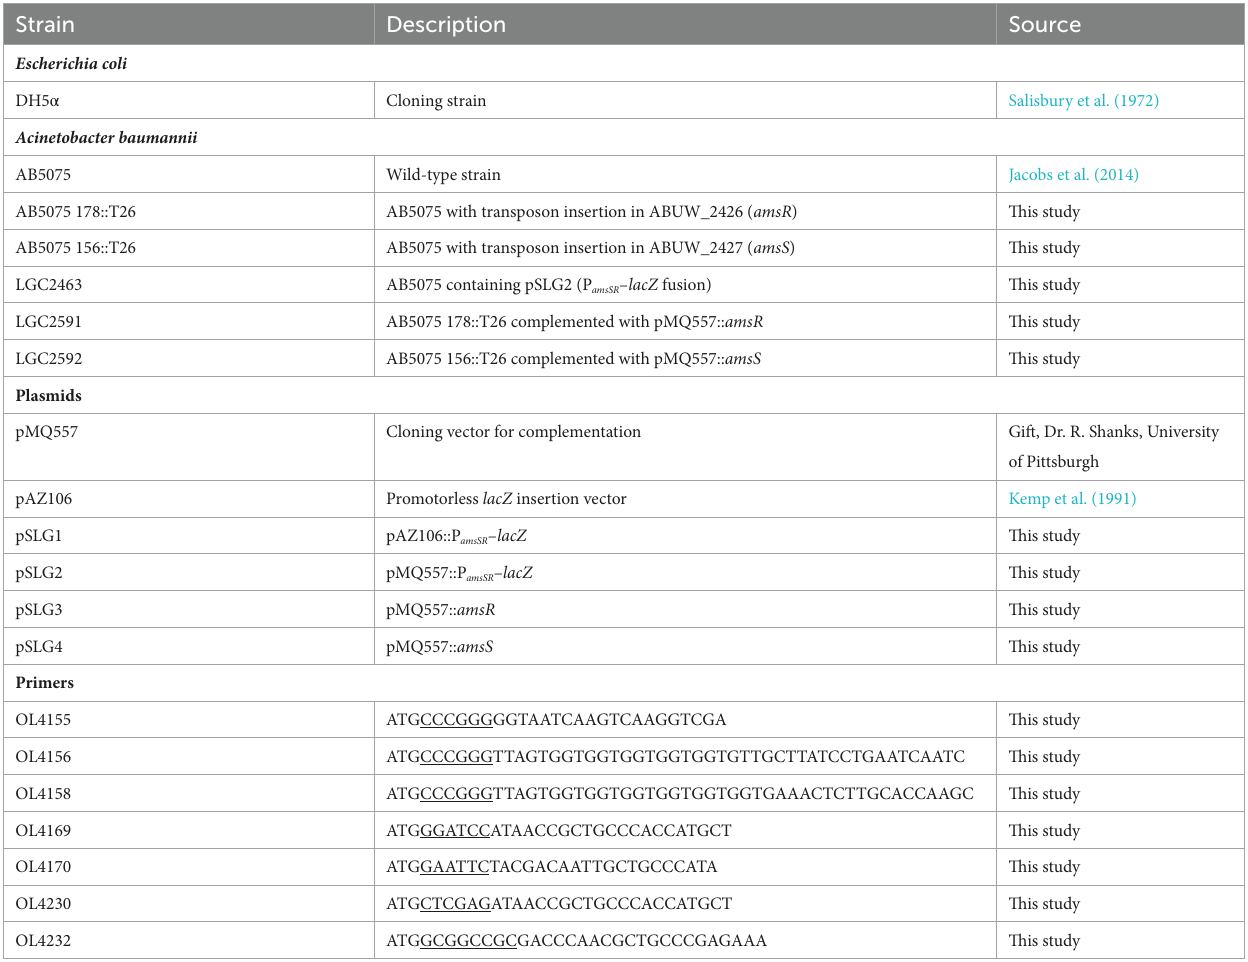
TABLE 1 Bacteria strains, plasmids, and cloning primers.